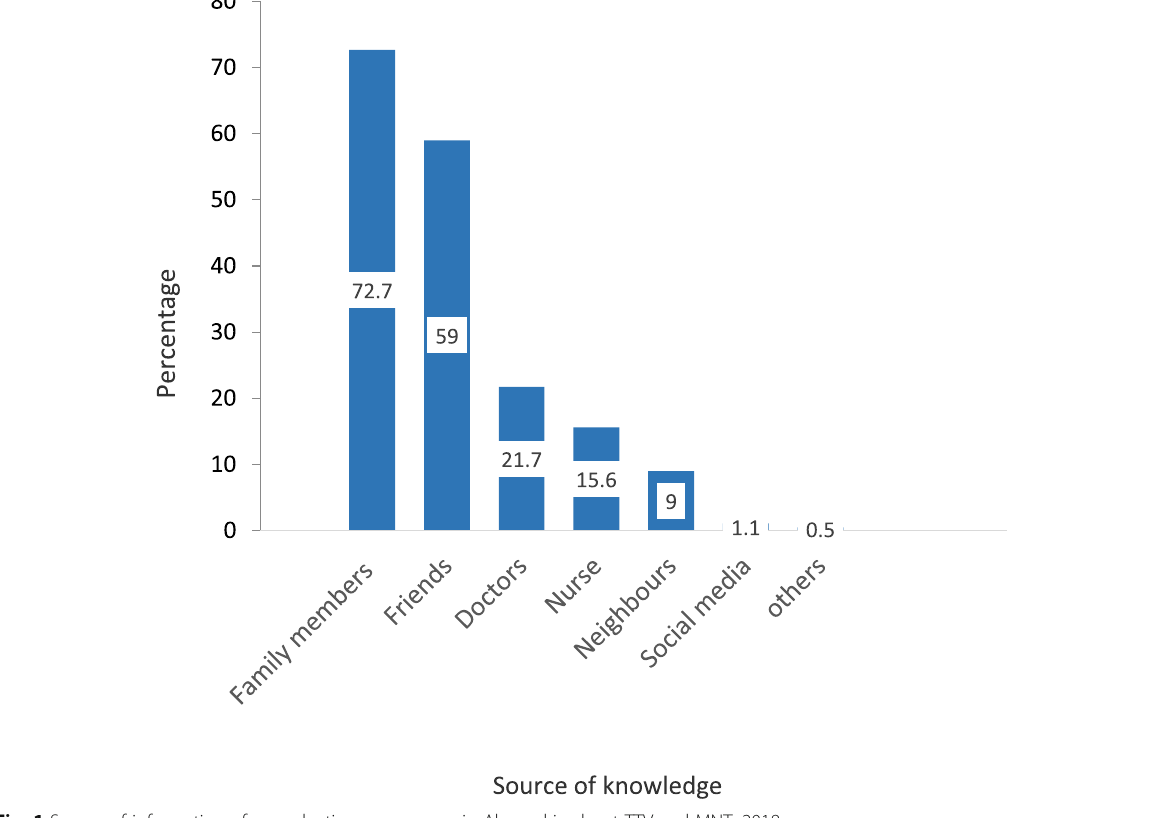
Fig. 1 Source of information of reproductive-age women in Alexandria about TTV and MNT,